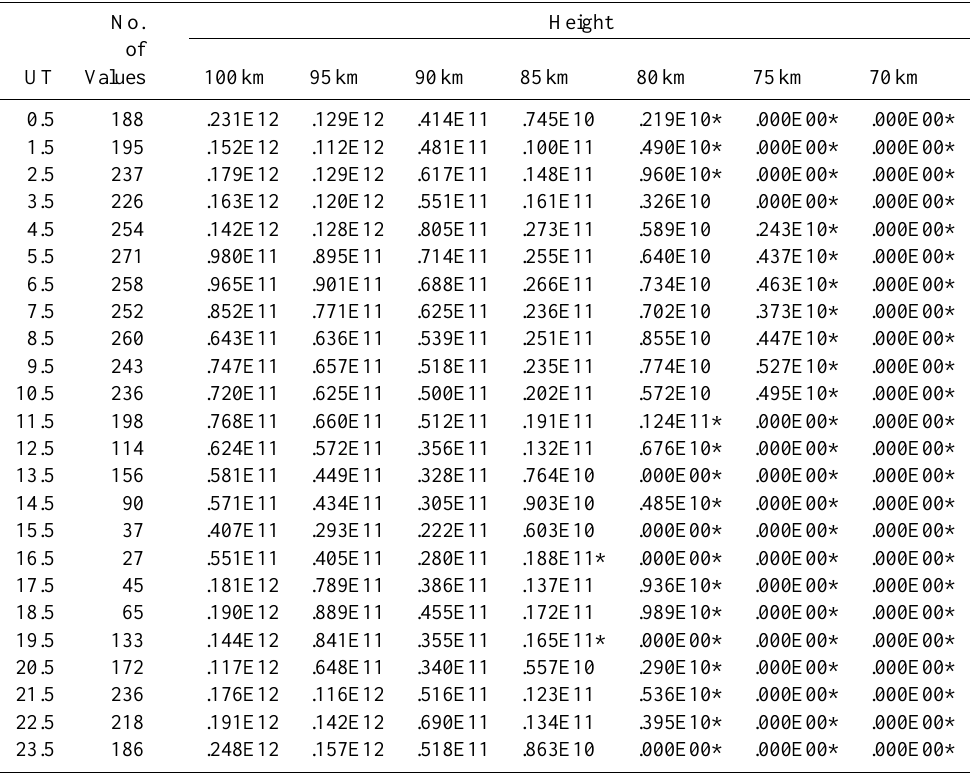
Table 1. Median electron density corresponding to 1dB absorption for each height and each hour of the day, using data from all years and months. The * indicates an upper